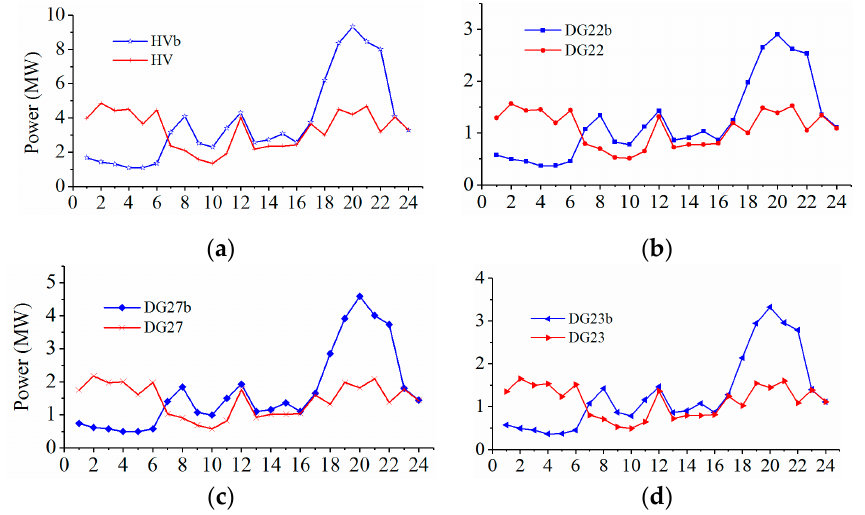
Figure 11. Optimized daily scheduling results for a typical household prosumer within RMG Power scheduling results of distributed generations in the distribution network ( a ) Power purchased from the upstream grid, which is indicated as HV; ( b ) Power output of the DG installed in bus 22; ( c ) Power